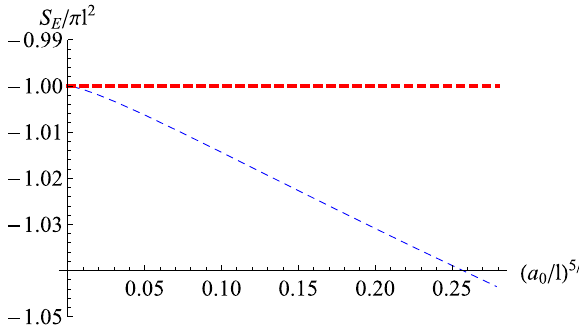
Fig. 3 S E /π(cid:9) 2 as a function of a 0 /(cid:9) . The blue dashed curve is that of Euclidean wormholes, while the red dashed curve is that of compact instantons. This shows that S E /π(cid:9) 2 (cid:3) − 1 − 0 . 16 ( a 0 /(cid:9)) 5 /